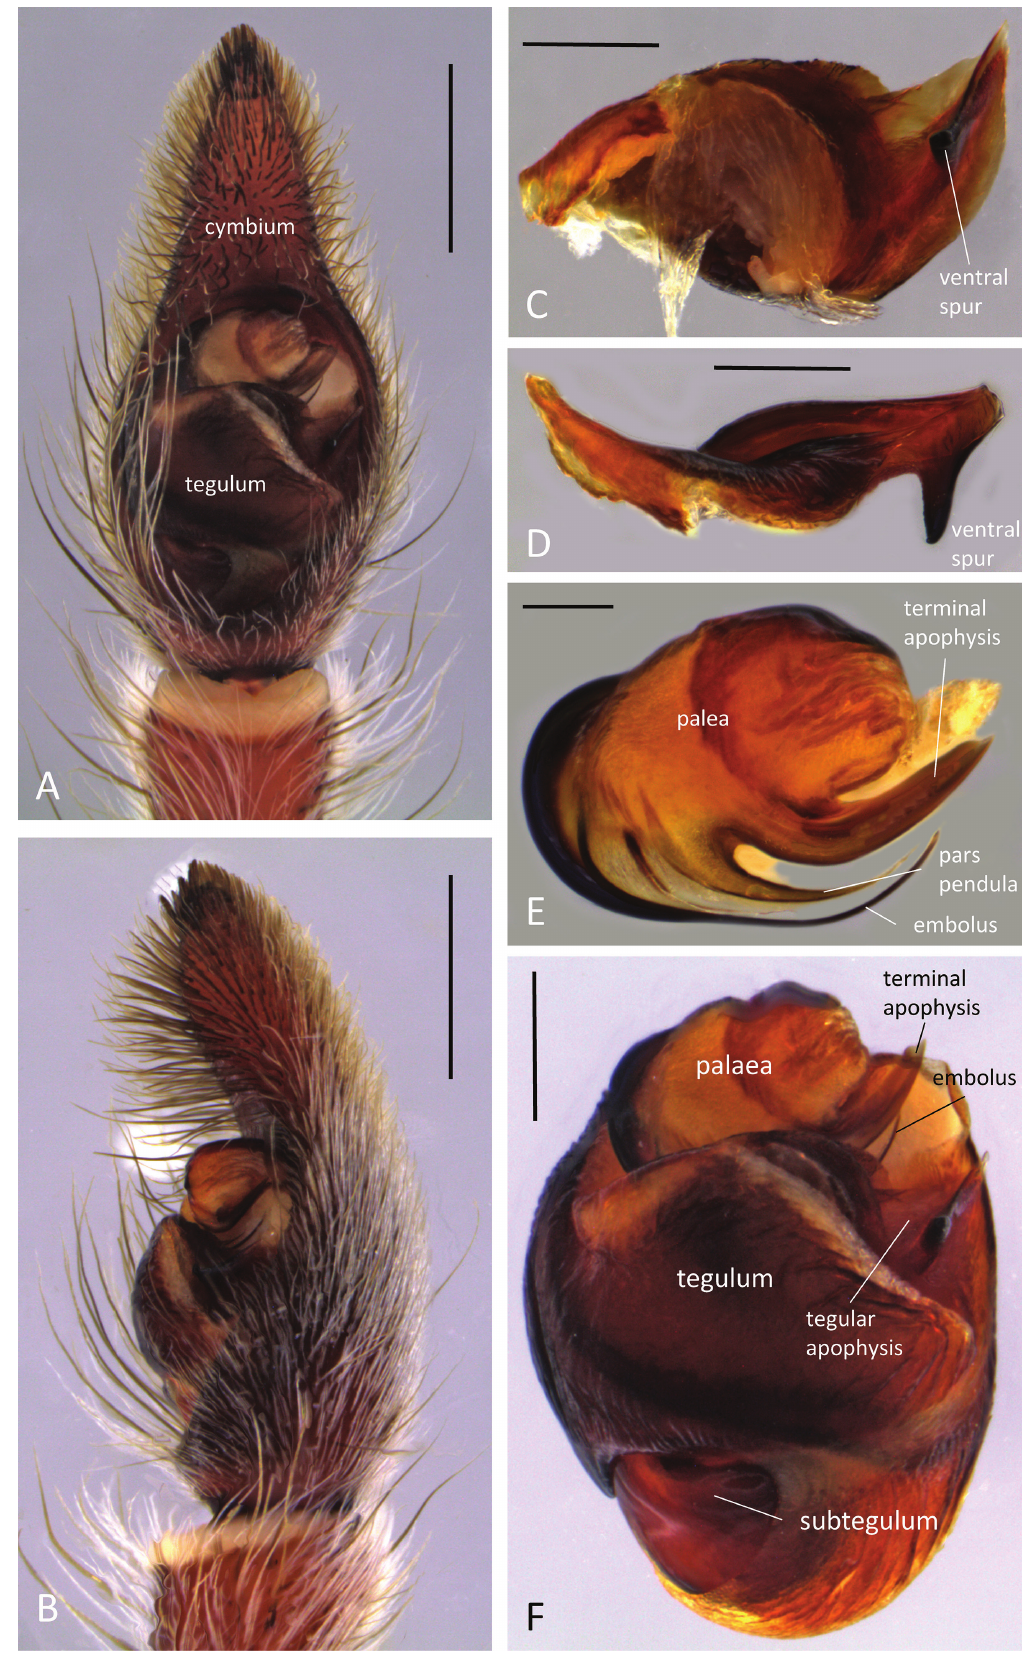
Figure 3. Portacosa cinerea gen. n. and sp. n., male holotype (WAM T68032), pedipalp. A, B, pedipalp, ventral ( A ) and retrolateral ( B ) view. C, D, tegular apophysis, ventral ( C ) and apical ( D ) view. E, palea, ventral view. F, pedipalp bulb (dissected from cymbium), ventral view. Scale bar: A, B – 0.75; C, D – 0.25; E – 0.11, F –